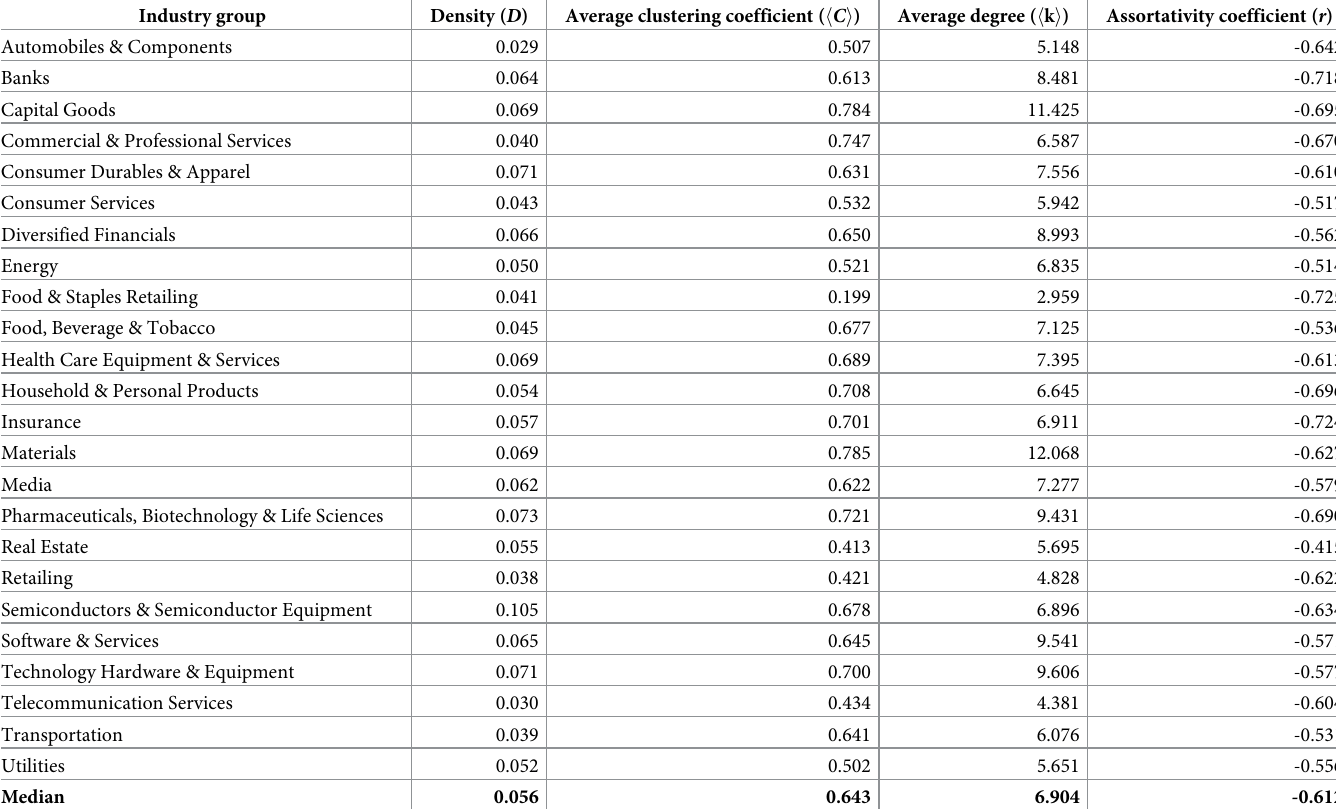
Table 2. Network properties of 24 GICS sector